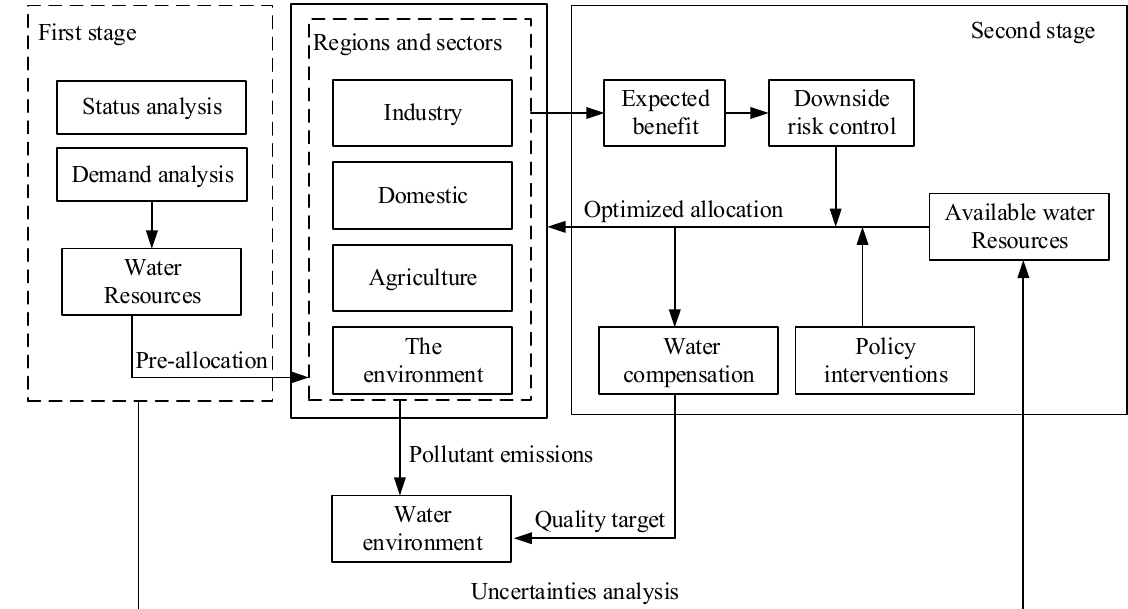
Figure 1. Framework for the inexact downside risk control and two-stage stochastic programming model.